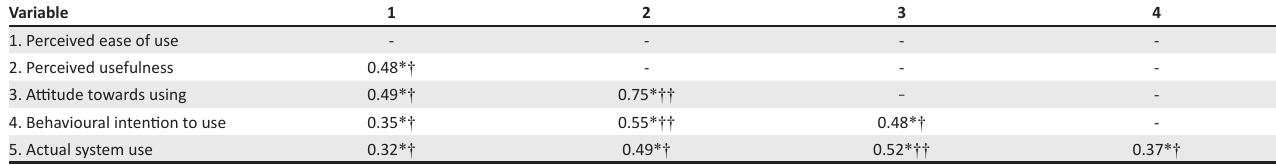
TABLE 5: Correlation coefficients between perceived ease of use, perceived usefulness, attitude towards using, behavioural intention to use and actual system use ( N = 241). Variable 1 2